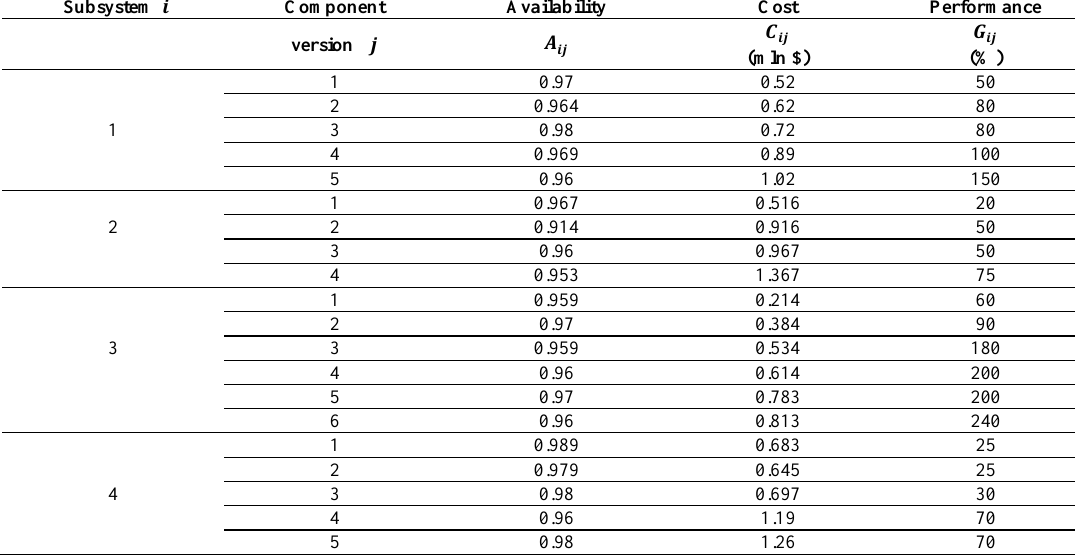
Table 9. Data of the components available in the market (Example 1).